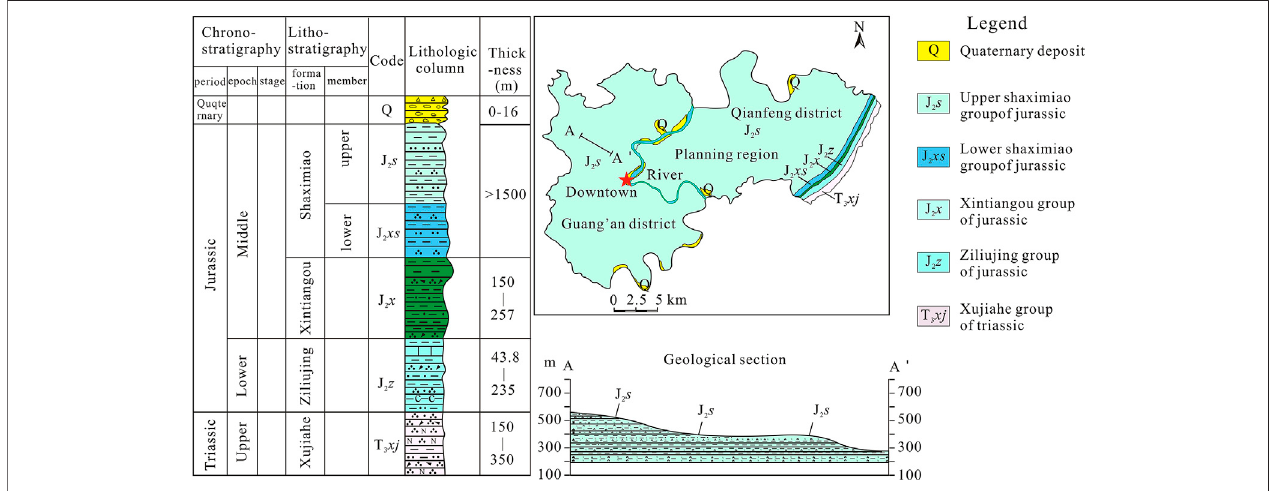
FIGURE 4 | Simpli fi ed geological map of the study area.